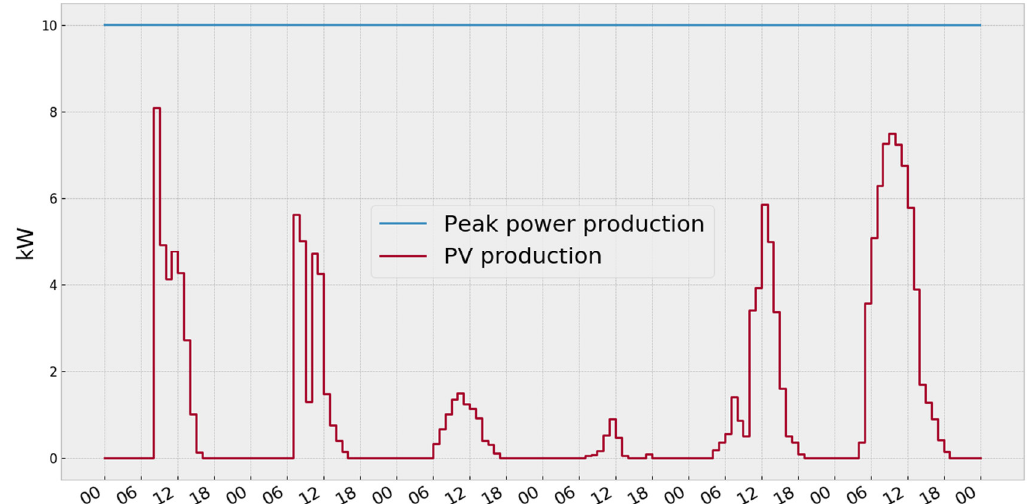
Figure 3. Plot of the microgrid PV generation for the one-week testing period.